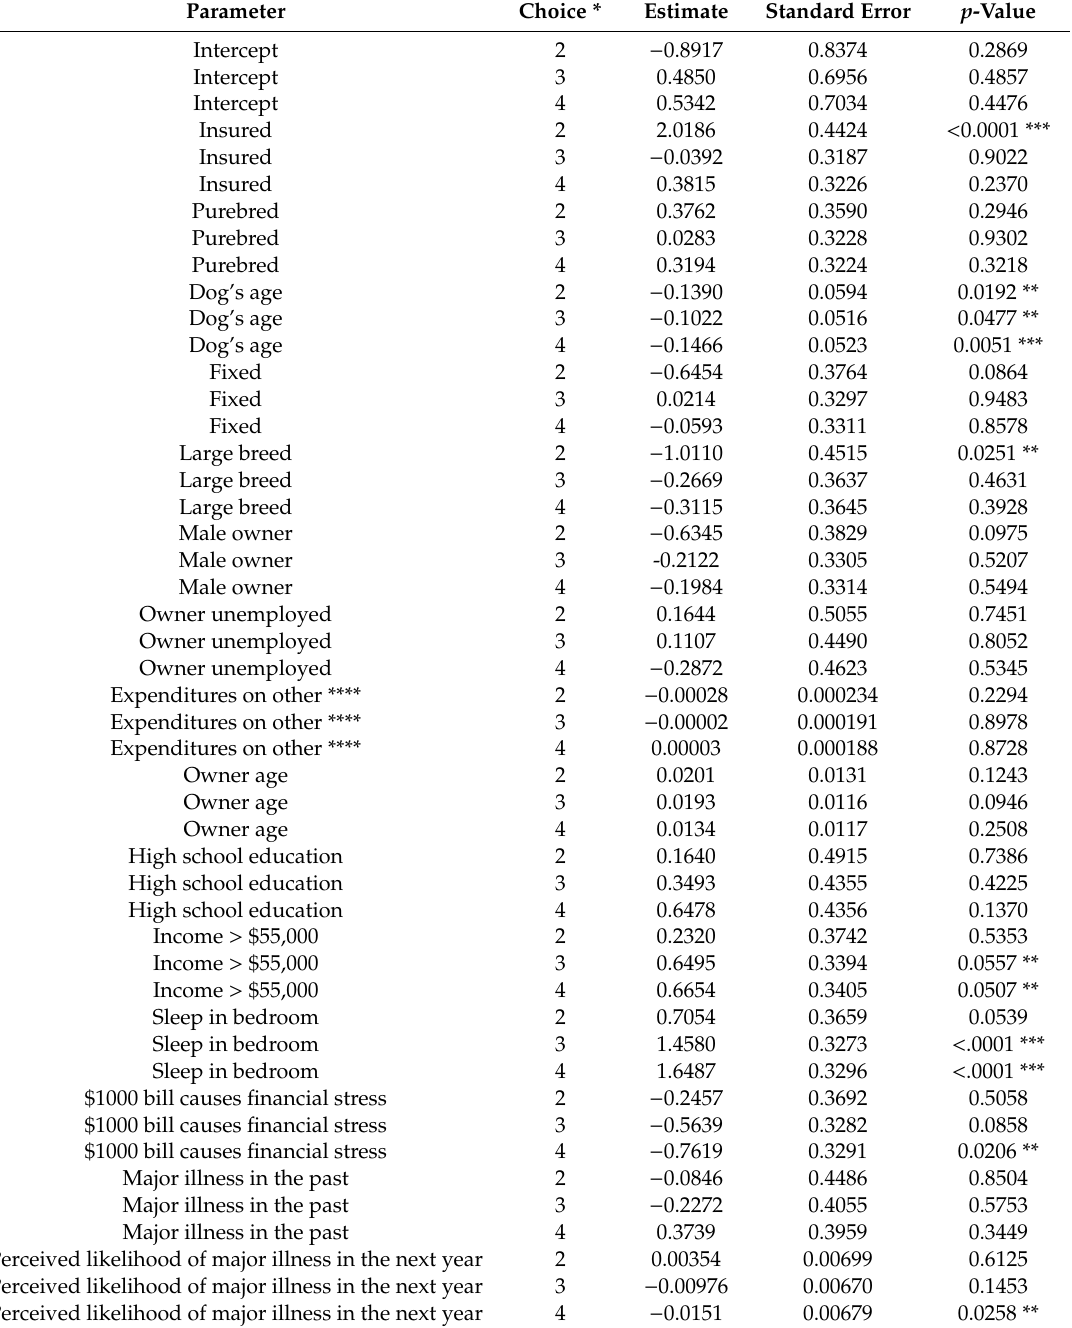
Table 6. Multinomial logit results where pet owners were posed with a hypothetical situation in which their pet faces a major health diagnosis and are given four treatment